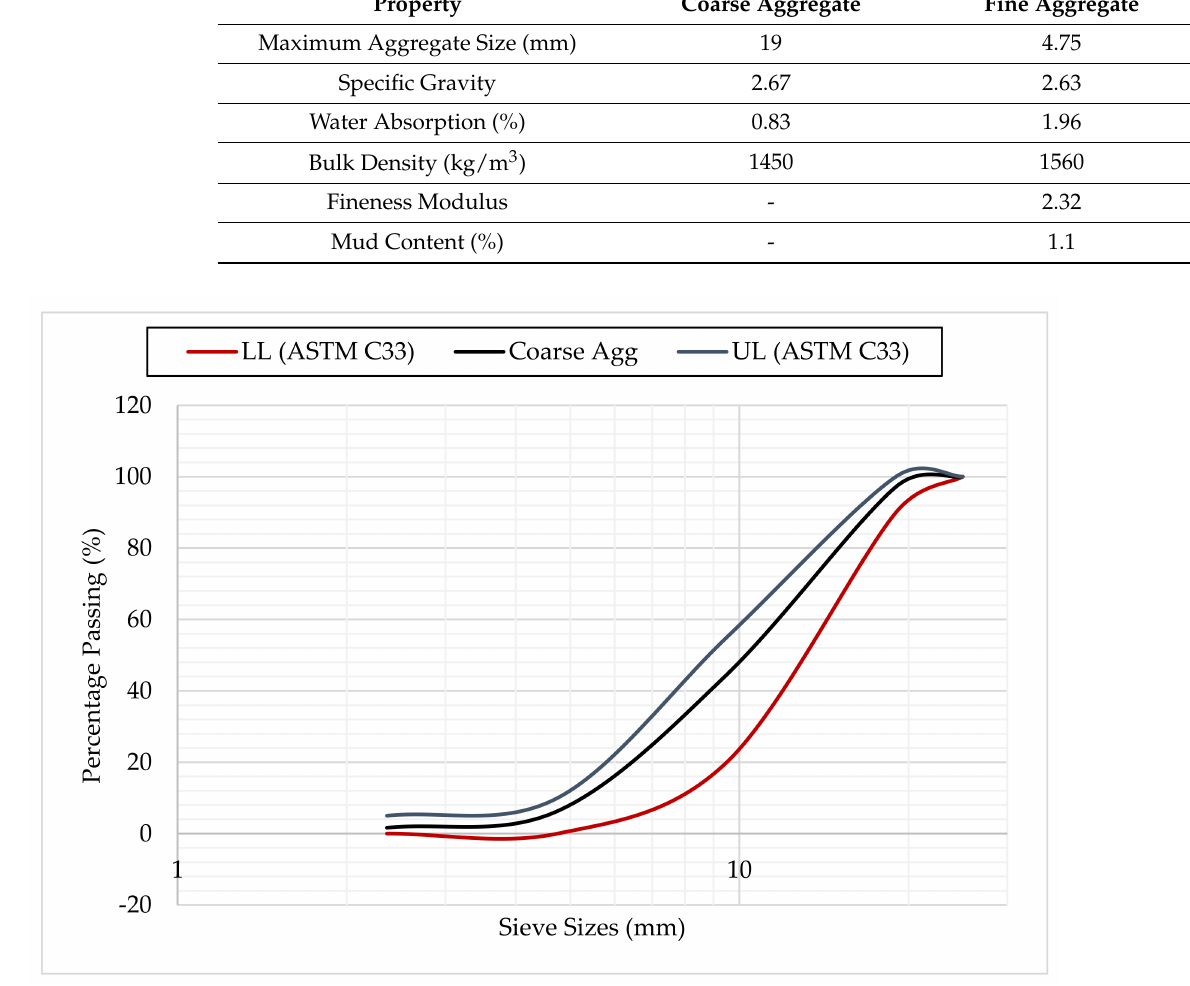
Figure 2. Particle Size Distribution of Coarse